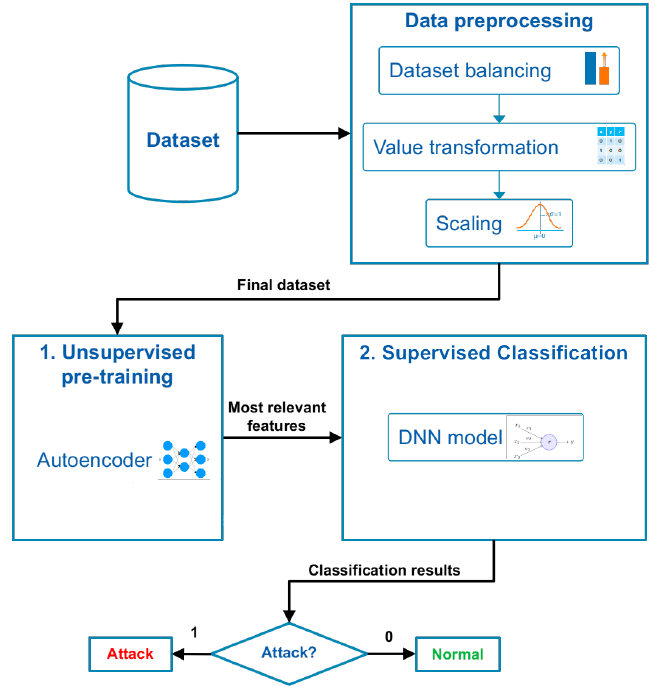
Figure 5. Workflow of the proposed